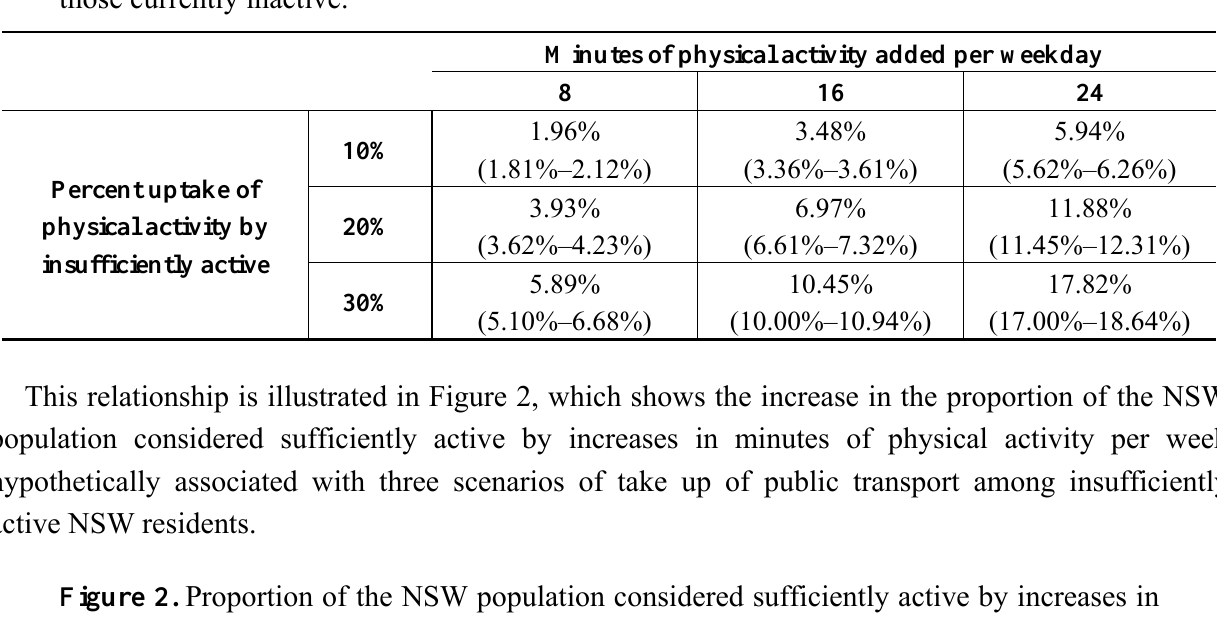
Figure 2. Proportion of the NSW population considered sufficiently active by increases in minutes of physical activity per week associated with three scenarios of take up of public transport among insufficiently active NSW